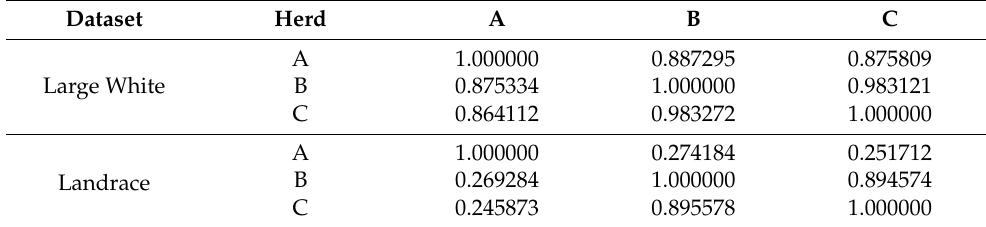
Table 4. Connectedness rating (CR) between herds for Large White and